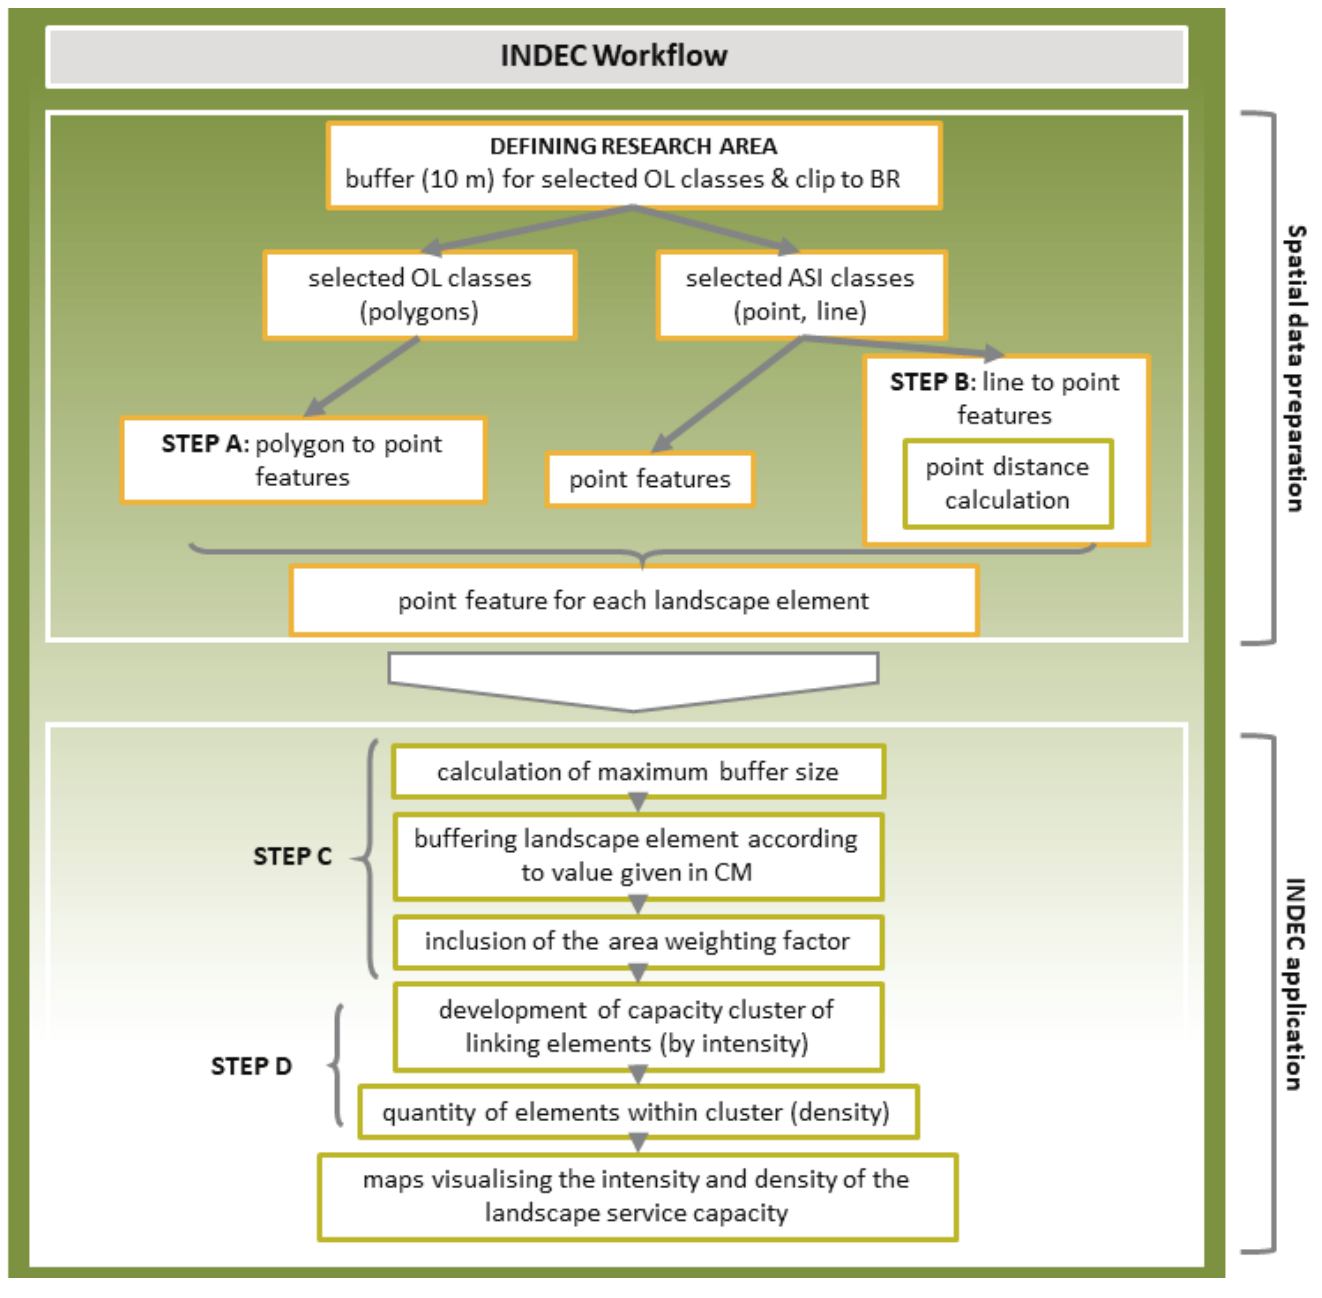
Figure 2: Workflow of the calculation steps, with spatial data preparation and INDEC (INtensity and DEnsity of service Capacity) application. OL: Open Land; ASI: Additional Spatial Indicators; CM: Capacity Matrix; BR: Biosphere